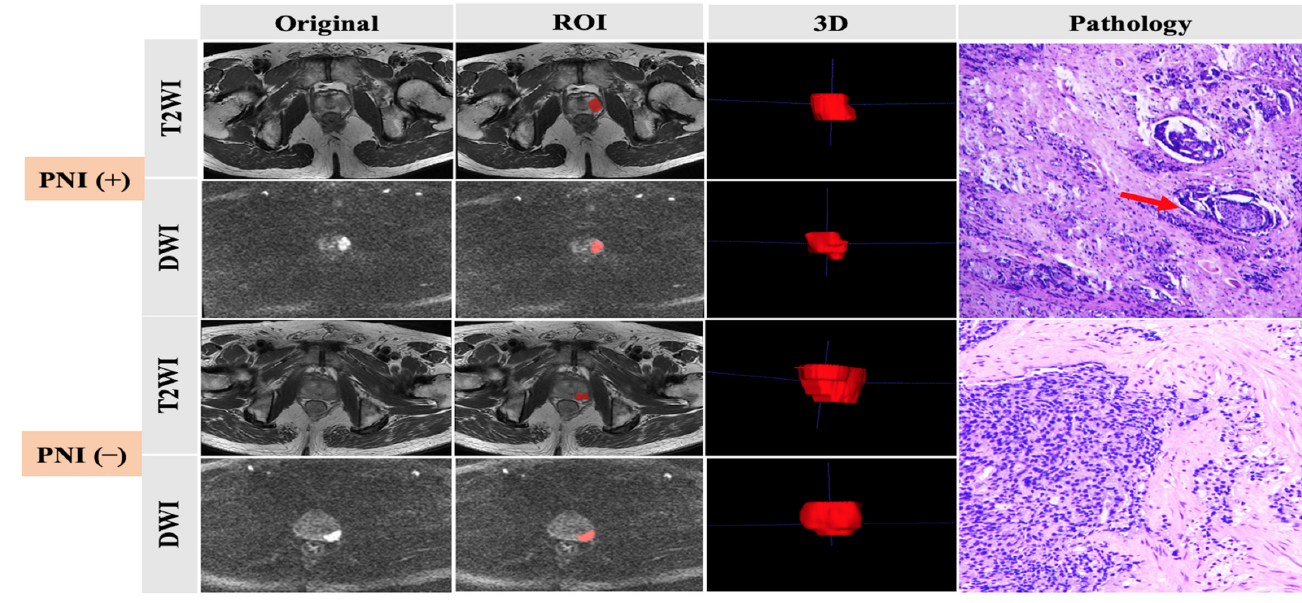
Figure 1. Preoperative MRI images, ROI delineation, and pathological comparison of prostate can- cer with and without PNI, as indicated by the arrow. with and without PNI, as indicated by the